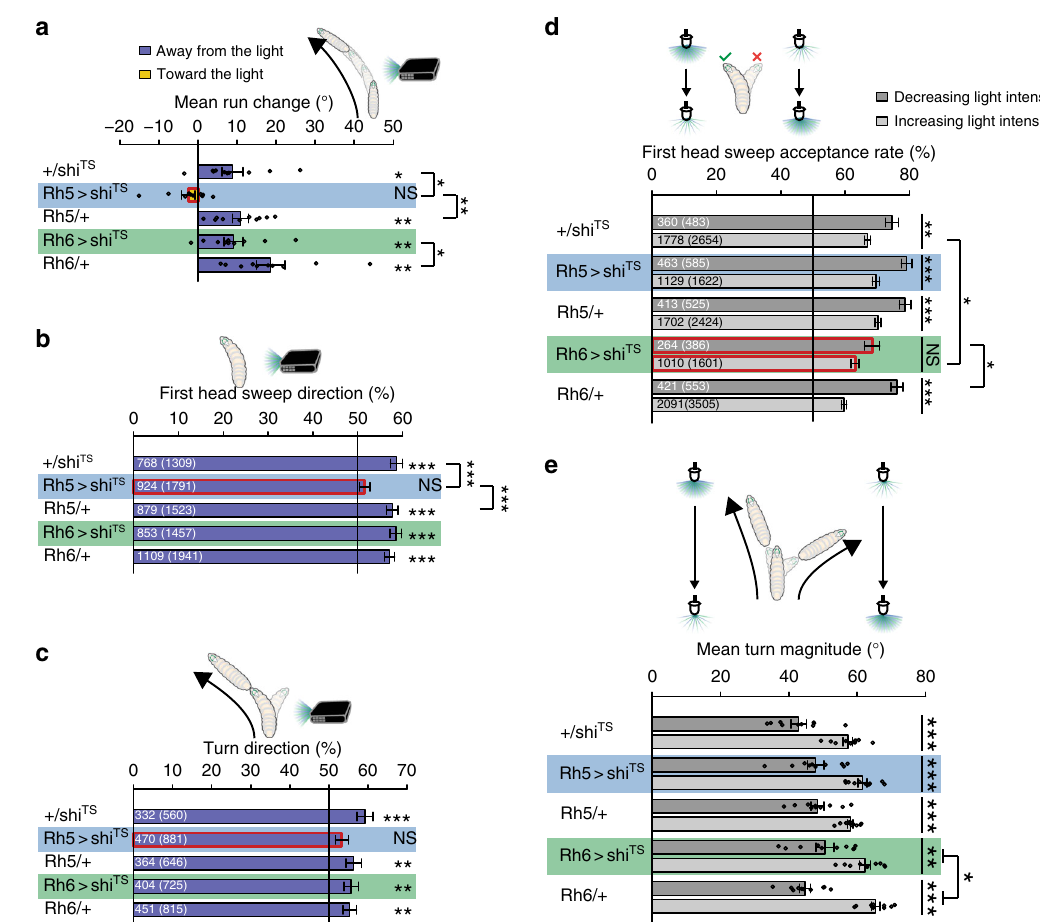
Fig. 4 Function of the two PR subtypes in phototaxis. a Rh5-PRs are necessary to steer away from the light. + / shi TS : n = 10, p = 0.011; Rh5 > shi TS : n = 10, p = 0.1844; Rh5 / + : n = 10, p = 0.0015; Rh6 > shi TS : n = 10, p = 0.0078; Rh6 / + : n = 10, p = 0.0015. Larvae with silenced Rh5-PRs show a decreased steering away from the light compared to controls. One-way ANOVA: p = 3.0 × 10 − 5 . Dunnett ’ s test: Rh5 > shi TS vs + / shi TS : p = 0.0122; Rh5 > shi TS vs Rh5 / + : p = 0.0024; Rh6 > shi TS vs + / shi TS : p = 1; Rh6 > shi TS vs Rh6 / + : p = 0.0412. b Functional Rh5-PRs are necessary to bias the fi rst head sweep direction. + / shi TS : n = 1309, p = 6.3 × 10 − 10 ; Rh5 > shi TS : n = 1791, p = 0.1857; Rh5 / + : n = 1523, p = 2.4 × 10 − 9 ; Rh6 > shi TS : n = 1457, p = 3.7 × 10 − 10 ; Rh6 / + : n = 1941, p = 6.3 × 10 − 10 . Only the probability of the fi rst head sweep direction of larvae lacking functional Rh5-PRs was statistically different from the controls. Rh5 > shi TS vs + / shi TS : p = 3.7 × 10 − 4 ; Rh5 > shi TS vs Rh5 / + : p = 9.3 × 10 − 4 ; Rh6 > shi TS vs + / shi TS : p = 0.9692; Rh6 > shi TS vs Rh6 / + : p = 0.5597. c Larvae lacking functional Rh5-PRs are not able to bias the direction of their turns away from the light source. + / shi TS : n = 560, p = 6.4 × 10 − 5 ; Rh5 > shi TS : n = 881, p = 0.0506; Rh5 / + : n = 646, p = 0.0032; Rh6 > shi TS : n = 725, p = 0.0032; Rh6 / + : n = 815, p = 0.0032. Rh5 > shi TS vs + / shi TS : p = 0.1182; Rh5 > shi TS vs Rh5 /